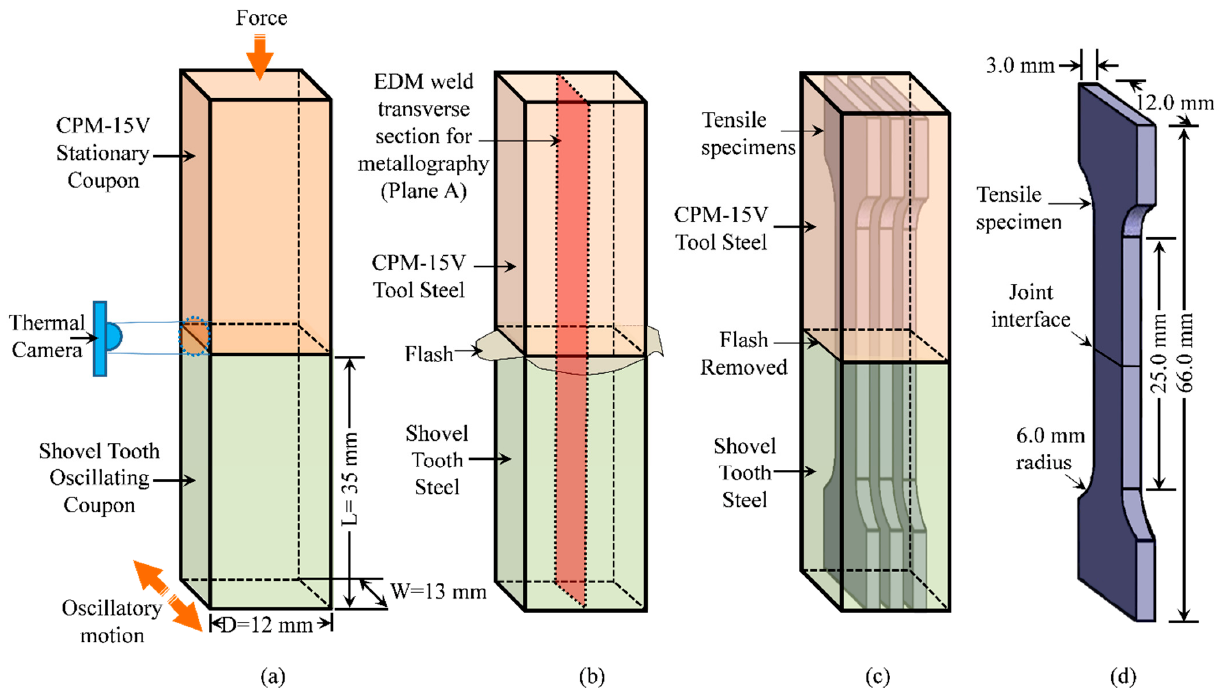
Figure 3. Schematic showing ( a ) the shovel-tooth steel and CPM 15V tool steel coupons, as well as their dimensions and configuration for LFW with a thermal camera; ( b ) the dissimilar material joint and extraction of transverse weld cross-section; ( c ) the extraction of tensile specimens from the weld; and ( d ) the subsize tensile specimen geometry that had a gage length of 25 mm, a width of 12 mm, and a thickness of 3 mm.